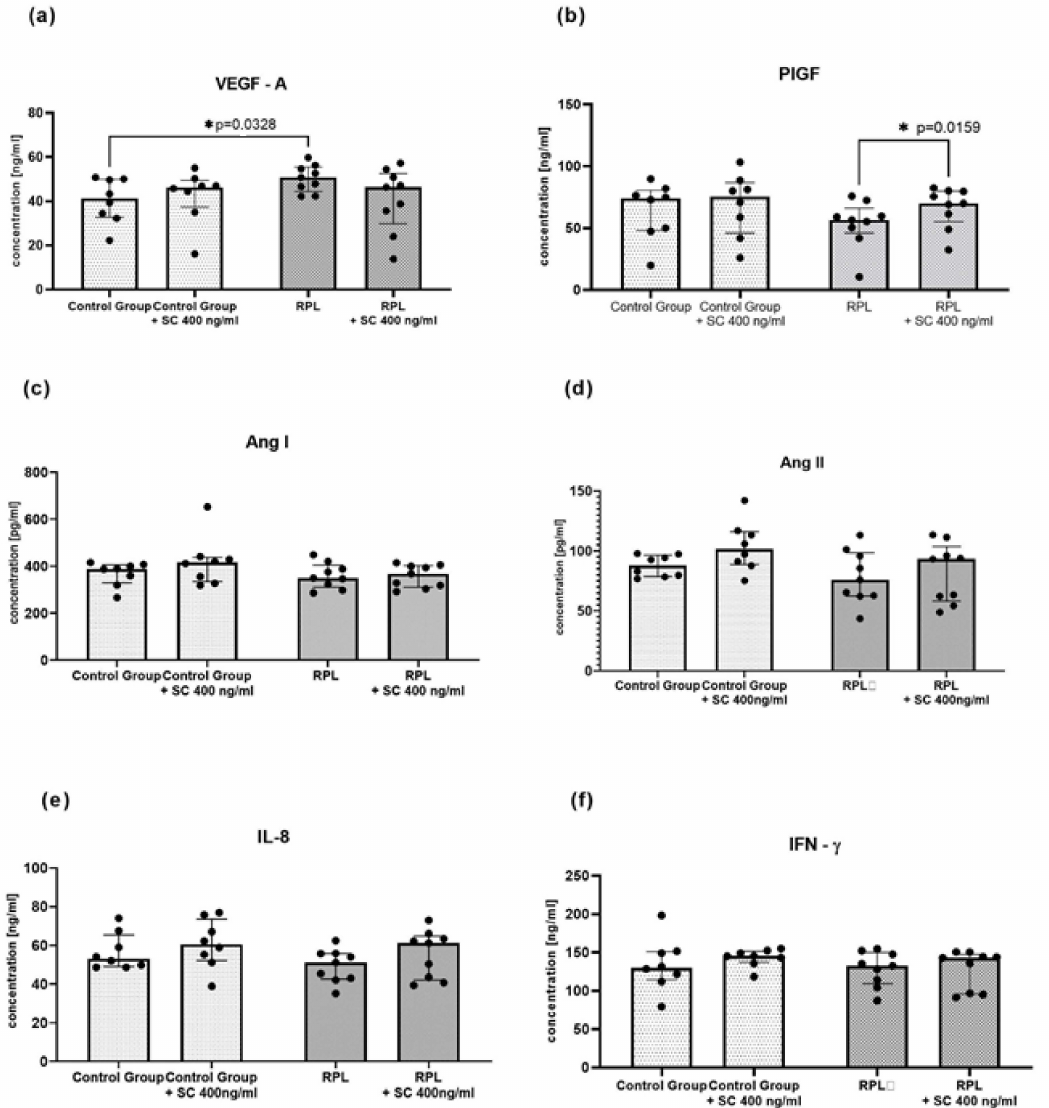
Figure 3. The concentrations of angiogenic factors and cytokines in idNK cultures with and without sildenafil citrate: ( a ) VEGF-A, ( b ) PIGF, ( c ) Ang I, ( d ) Ang II, ( e ) IL-8; ( f ) IFN- γ ; Control group n = 9, RPL patients n = 8; dots on the figures reflects numbers of determined samples, SC—sildenafil citrate 400 ng/mL, statistical significance marked as star—* p <